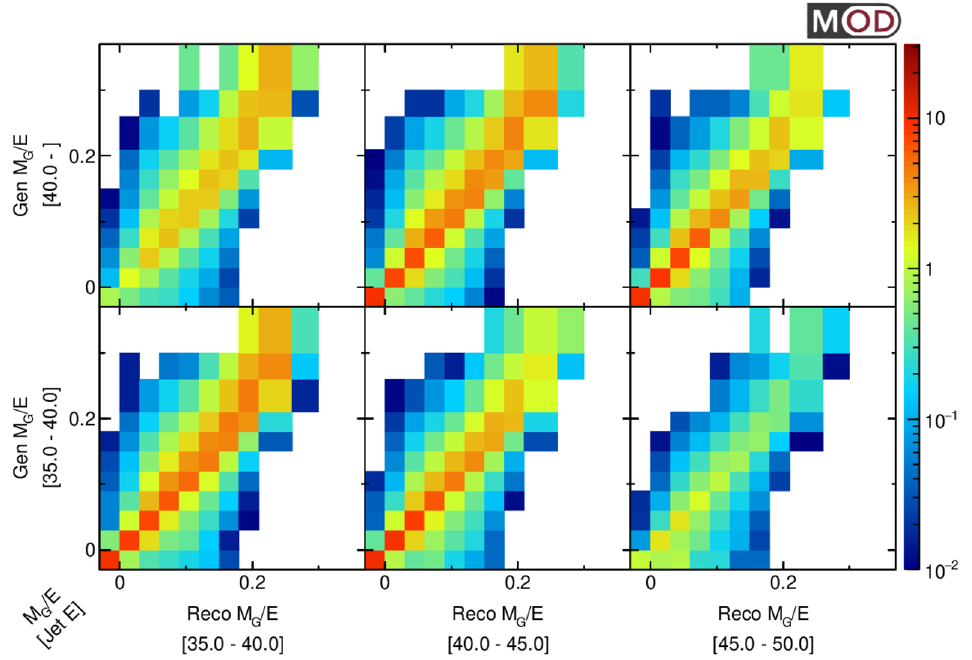
Figure 4 . Partial response matrix for M G /E , in bins of E . Each block is the sub-matrix for the indicated E range. The matrix is row-normalized across all E ranges: the color scale indicates the probability density of a given generator level (“Gen”) jet being smeared into a different reconstructed level (“Reco”)